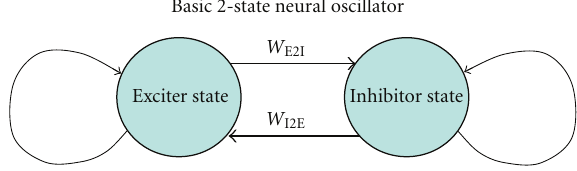
Figure 1: Basic 2-state oscillator. When the output of the system has reached the maximum, value control moves to the Inhibitor state, after the final value is multiplied by the Exciter to Inhibitor weight W E2I . The reverse happens in the Inhibitor state.